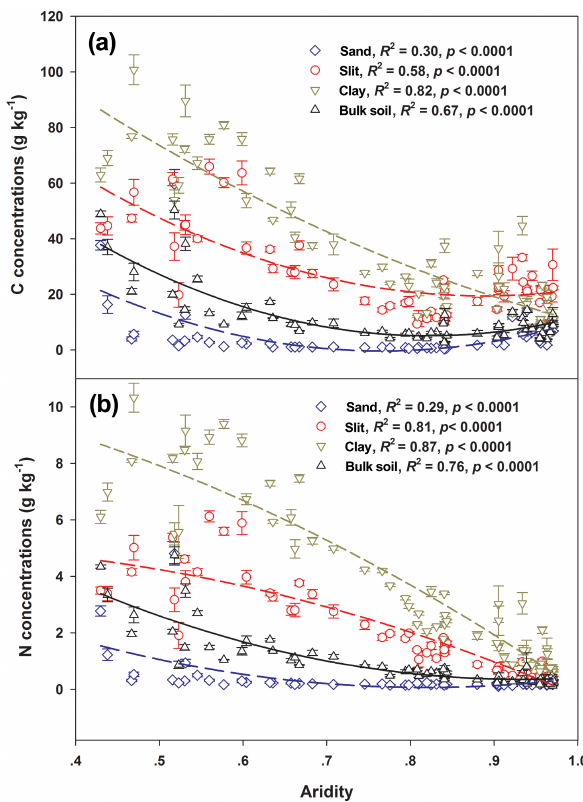
Figure 3. The C (a) and N stocks (b) in bulk soil and soil particle– size fractions were generally negatively correlated with aridity. Data are presented as mean ± 1SE ( n =